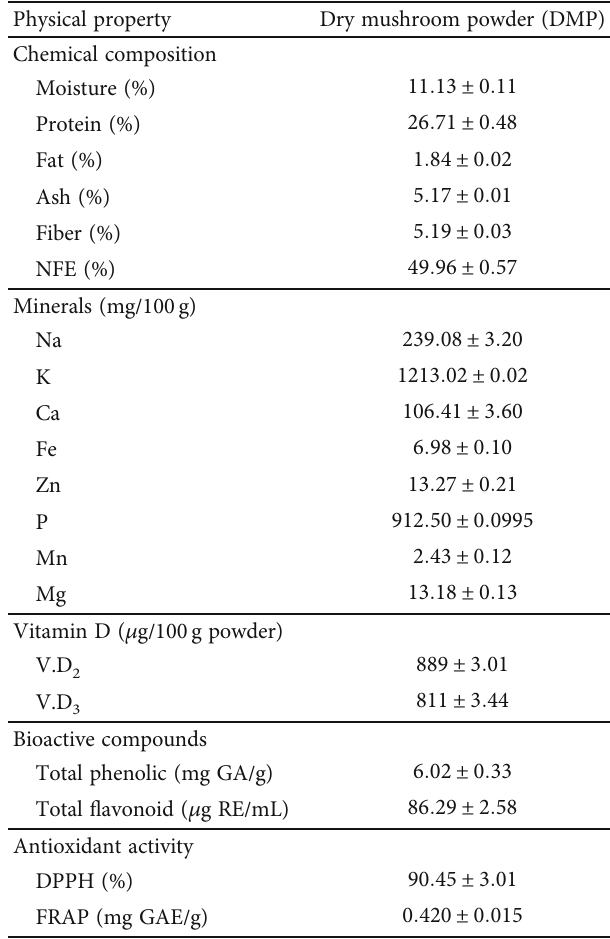
Table 4: Chemical composition, mineral content, vitamin D content, bioactive compounds, and antioxidant activity of dry mushroom powder (DMP) exposed to sunlight (60